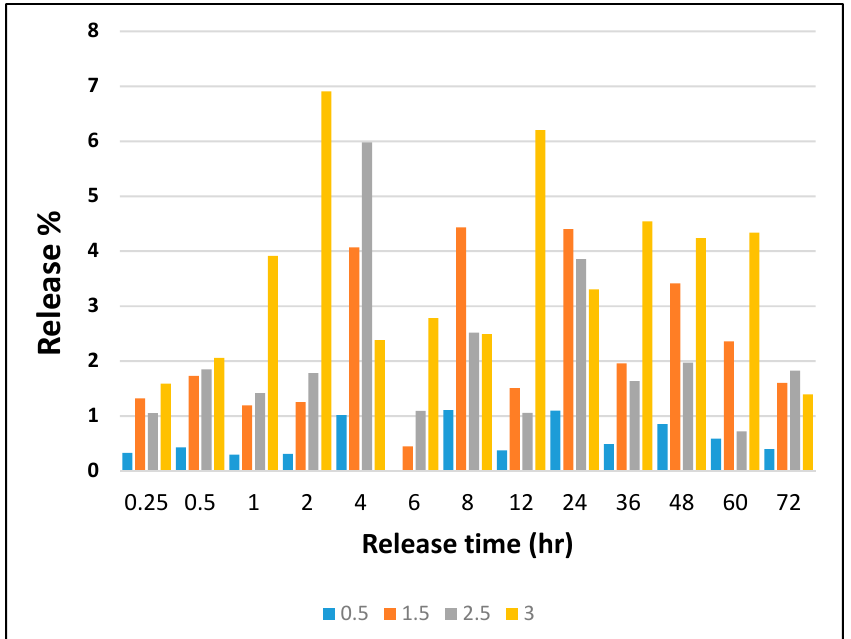
Figure 8. Release analysis by ICP study.